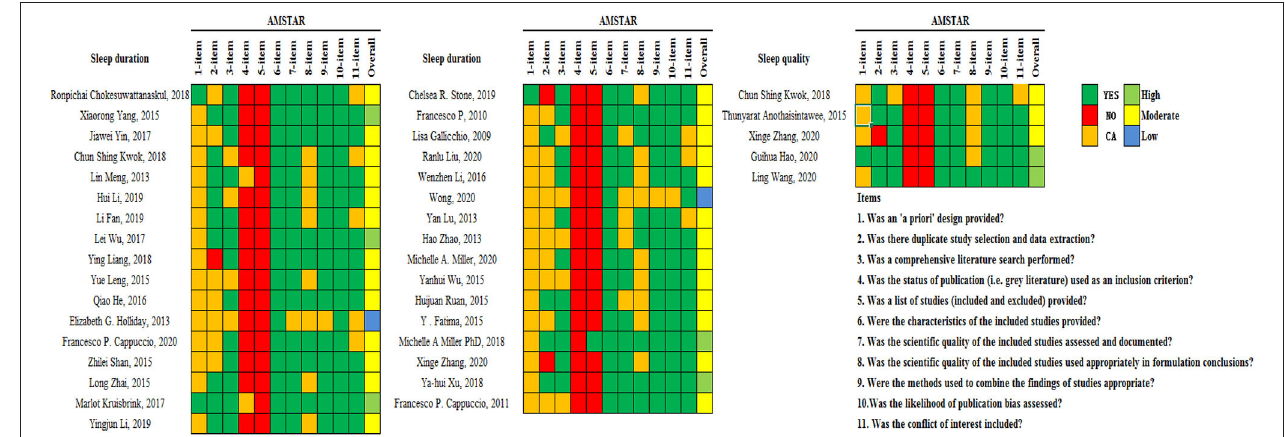
FIGURE 2 | Detailed evaluation of the methodological quality with